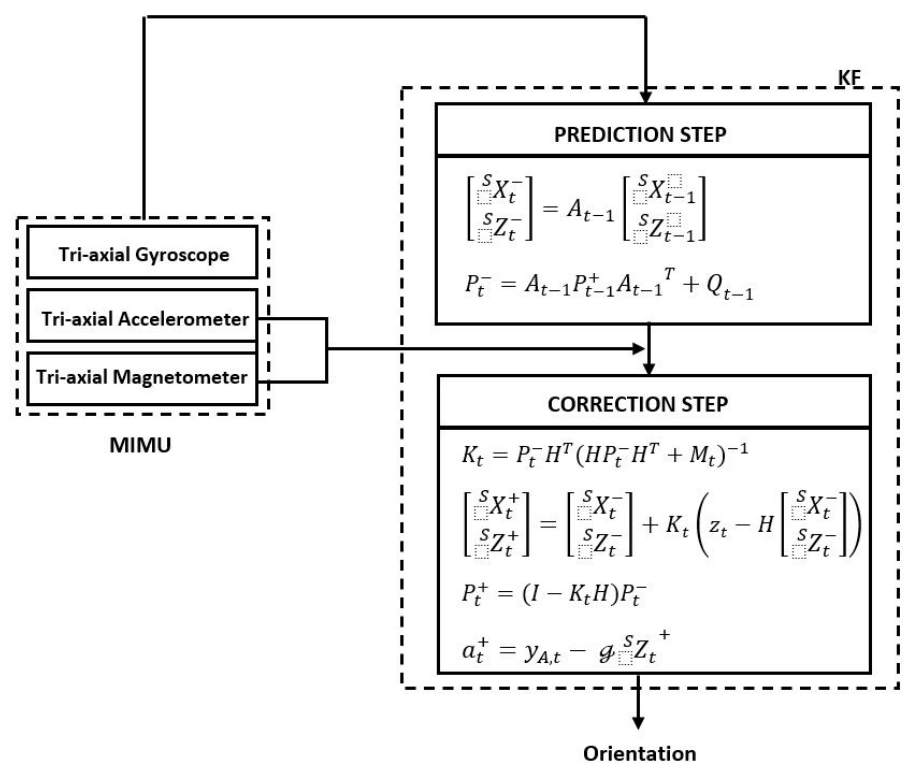
Figure 4. Chart of all the steps of the proposed Kalman filter algorithm, structured in two phases: the prediction and correction phases. (The image has been corrected)